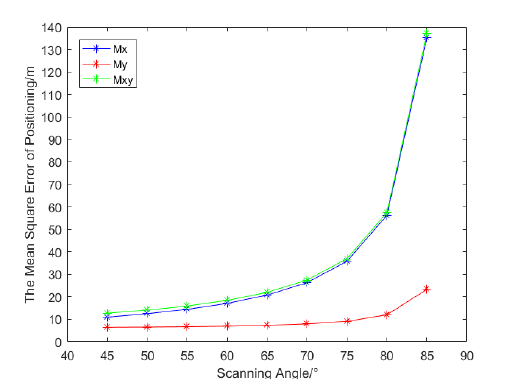
Figure 3 . The Positioning MSE at Different Whiskbroom Angles(4000m).